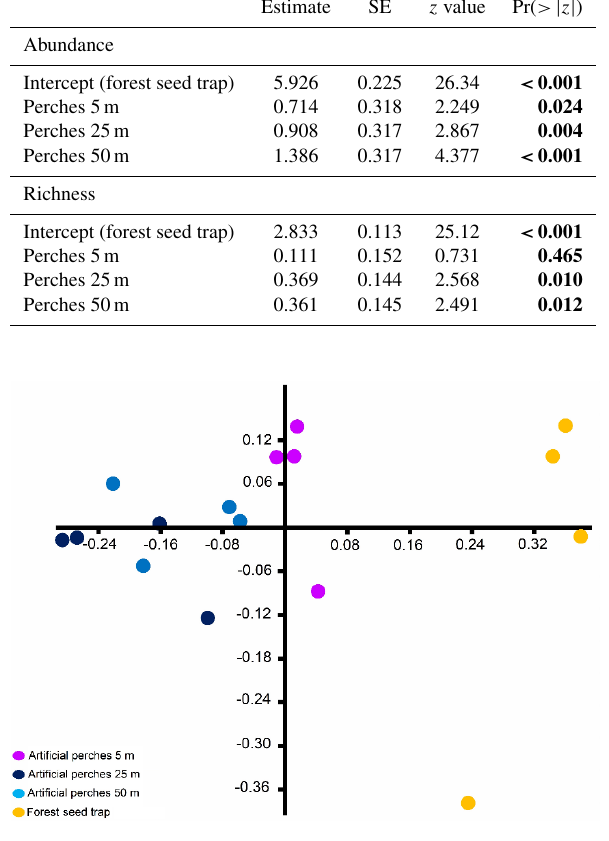
Figure 4. Non-metric multidimensional scaling (stress: 0.076) or- dination based on Bray–Curtis dissimilarity of seed community de- posited under artificial perches and forest seed traps sampled at the Cascata Experimental Station, southern Brazil.